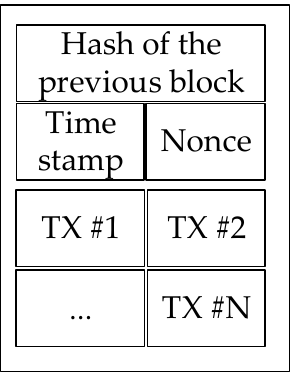
Figure 2. An example of a generic block.